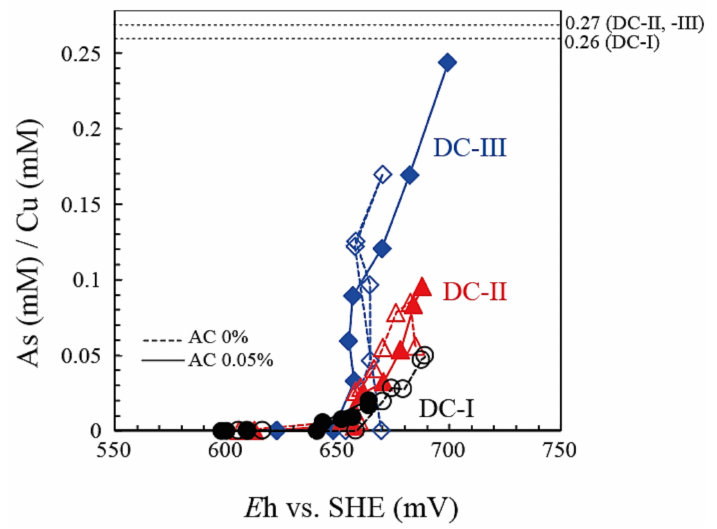
Figure 4. The molar ratio of [soluble As]/[soluble Cu] in the bioleached liquor as a function of E h (vs. SHE) during bioleaching of DC-I ( • , ), DC-II ( (cid:78) , (cid:52) ) and DC-III ( (cid:117) , ) at AC 0% (dotted line) (cid:35) (cid:51) or at AC 0.05% (solid lines). Dotted horizontal lines indicate the theoretical As/Cu ratio upon the complete dissolution of each concentrate based on Table